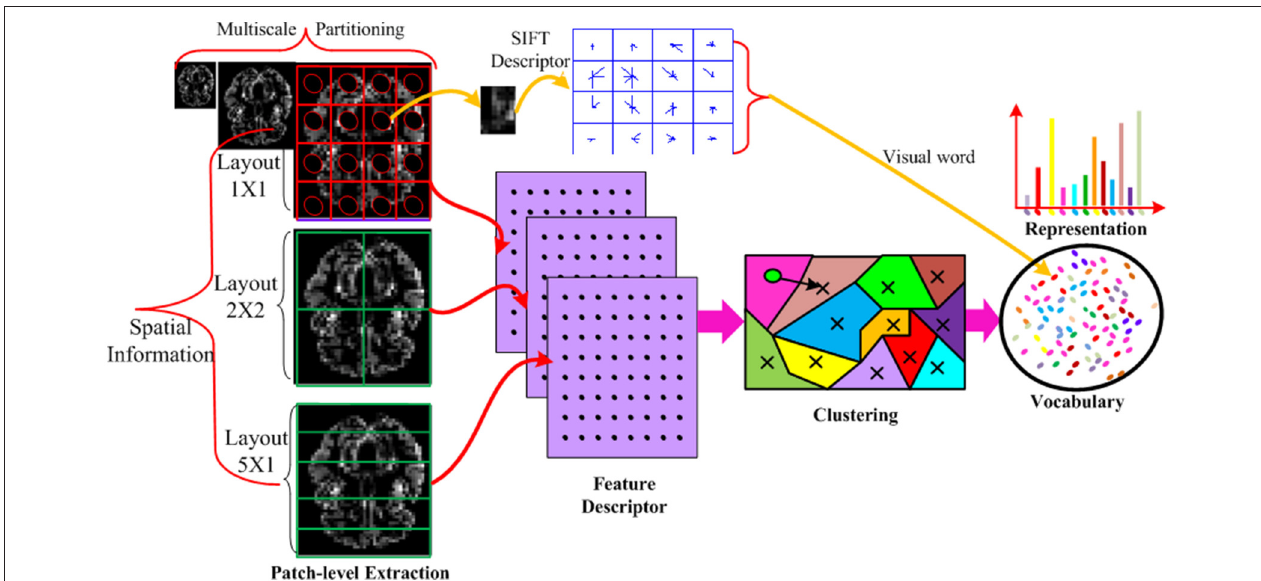
FIGURE 2 | Illustration of the feature vector formation using MRI imaging data only. Each MRI imaging data is partitioned into different layouts using multi-scale techniques. In each patch, a SIFT feature is calculated and vector quantized into a visual word. The SIFT descriptor is extracted from all patches, all scales and all layouts. The descriptors from all the training data are mapped to visual words by K -means clustering technique to build a visual word vocabulary. The histogram of the BoVW representation is simply an occurrence count of the number of SIFT vectors assigned to each visual word. In the representation, the histogram has K bins generated by K -means. Each bin denotes an occurrence count of the SIFT vectors associated with that visual word. In this way, the imaging data is encoded into a feature